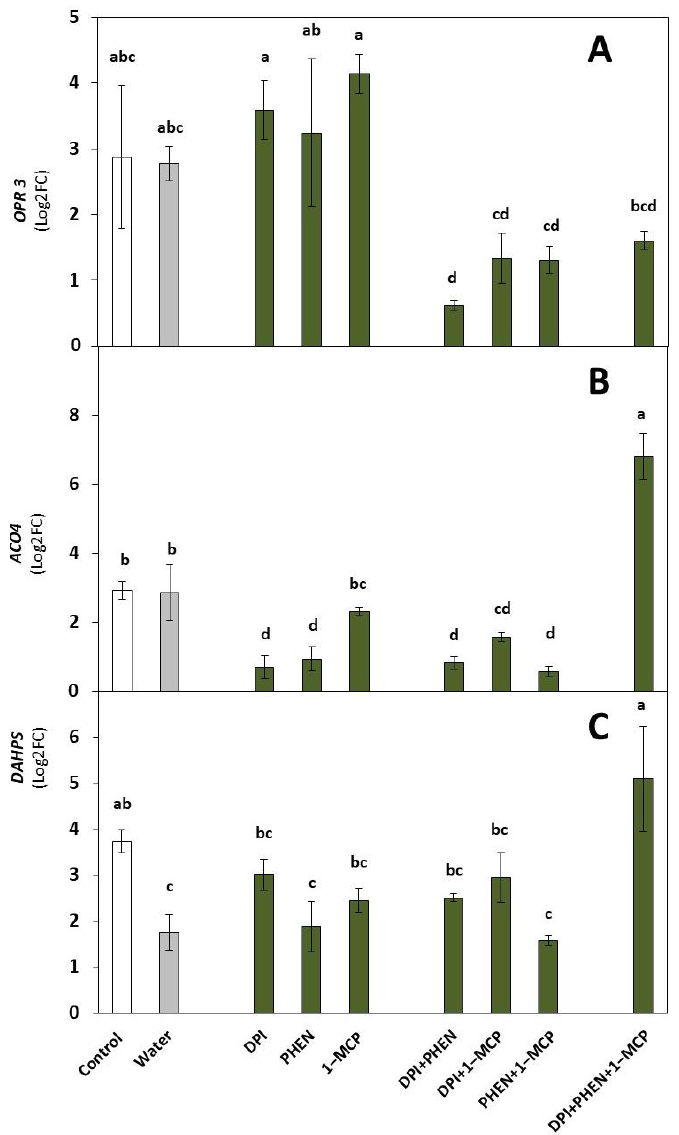
Figure 1. Effect of diphenyleneiodonium chloride (DPI), phenidone (PHEN), and 1-methylcyclopropene (1-MCP) on the relative expression of genes related to the biosynthesis of stress-signaling molecules and primary metabolites. 12-oxophytodienoate reductase 3 ( OPR3 , ( A )); 1-aminocyclopropane-1-carboxylate oxidase ( ACO4 , ( B )); 3-deoxy-D-arabino-heptulosonate synthase ( DAHPS , ( C )). Relative expression is shown at 1 h after wounding. Data represent the mean of 3 replicates ± standard error of the mean. Bars with different letters indicate statistical differences according to the LSD test ( p < 0.05).